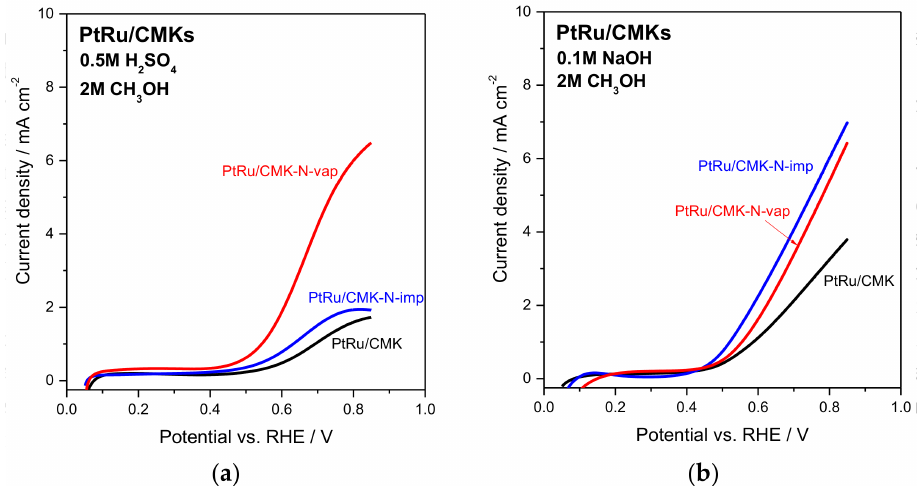
Figure 6. Electrooxidation of methanol by linear sweep voltammetry at 20 mV s − 1 in deareated 2 M methanol (CH 3 OH) in: ( a ) 0.5 M H 2 SO 4 electrolyte; ( b ) 0.1 M NaOH electrolyte. Room temperature, 50 µ g PtRu cm − 2